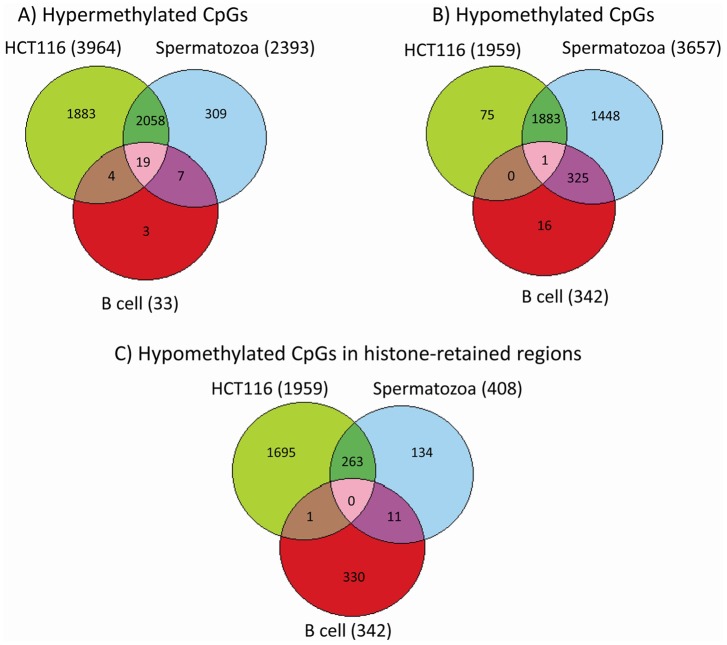
Venn diagram reporting unique and overlapping CpGs in/between the
three cell types.A) Hypermethylated CpGs. B) Hypomethylated CpGs. C) Hypomethylated
CpGs in histone-retained regions. HCT116: colorectal cancer cell
line.